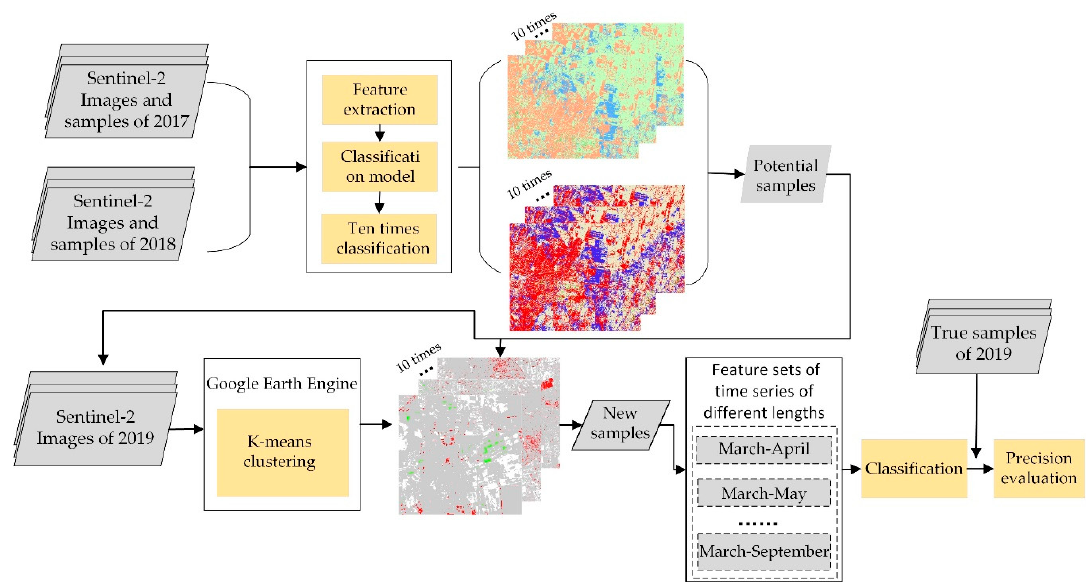
Figure 4. New samples extracted by historical sample section.